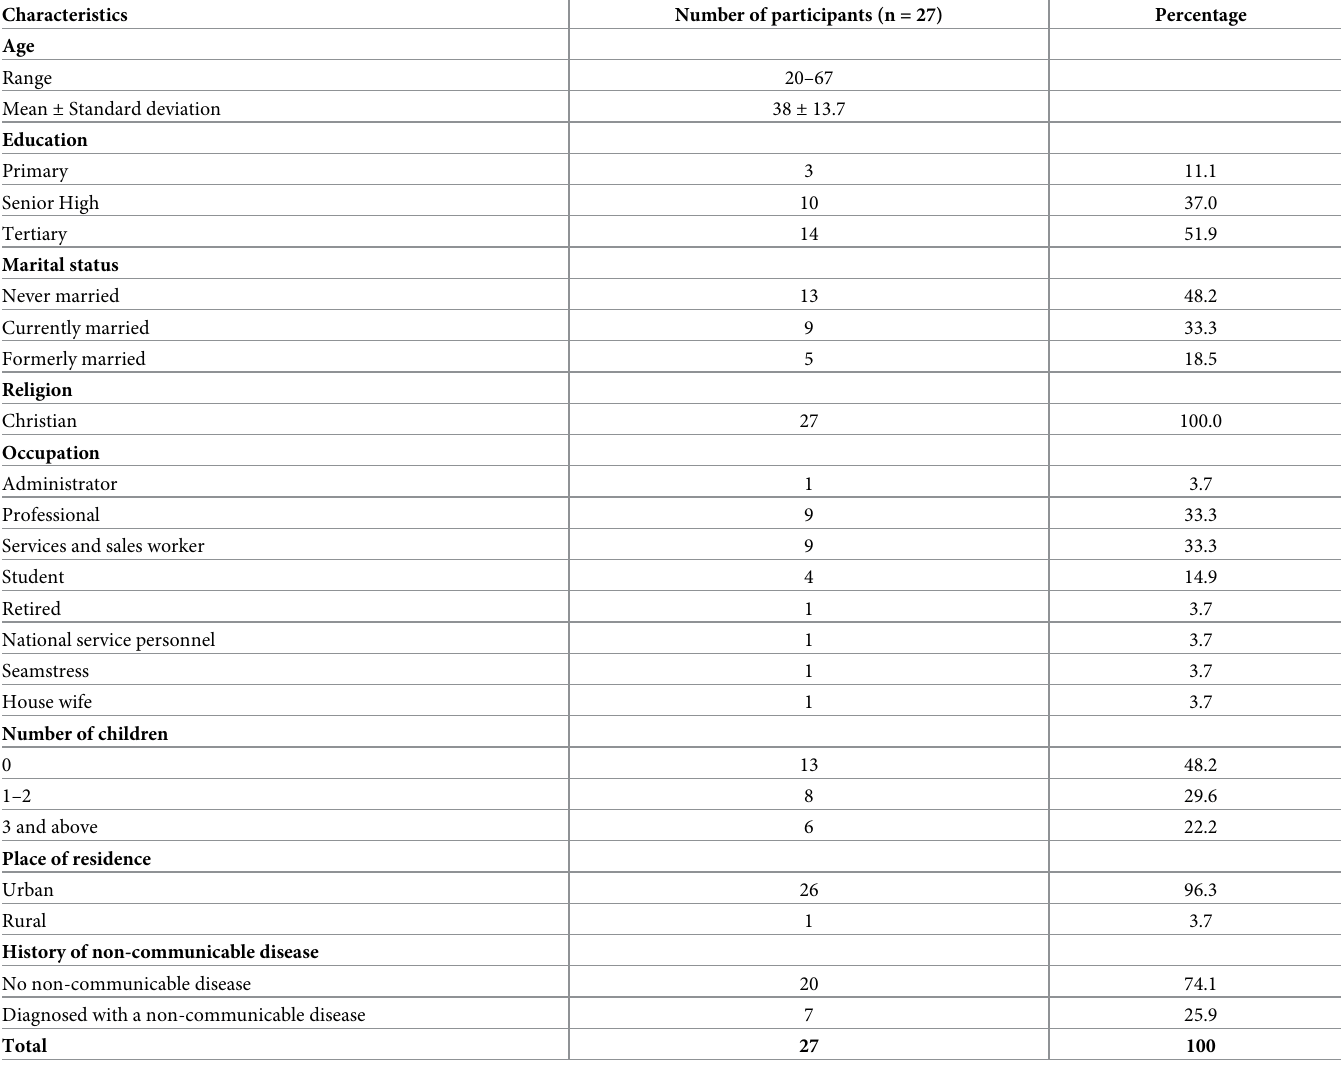
Table 1. Socio-demographic characteristics of